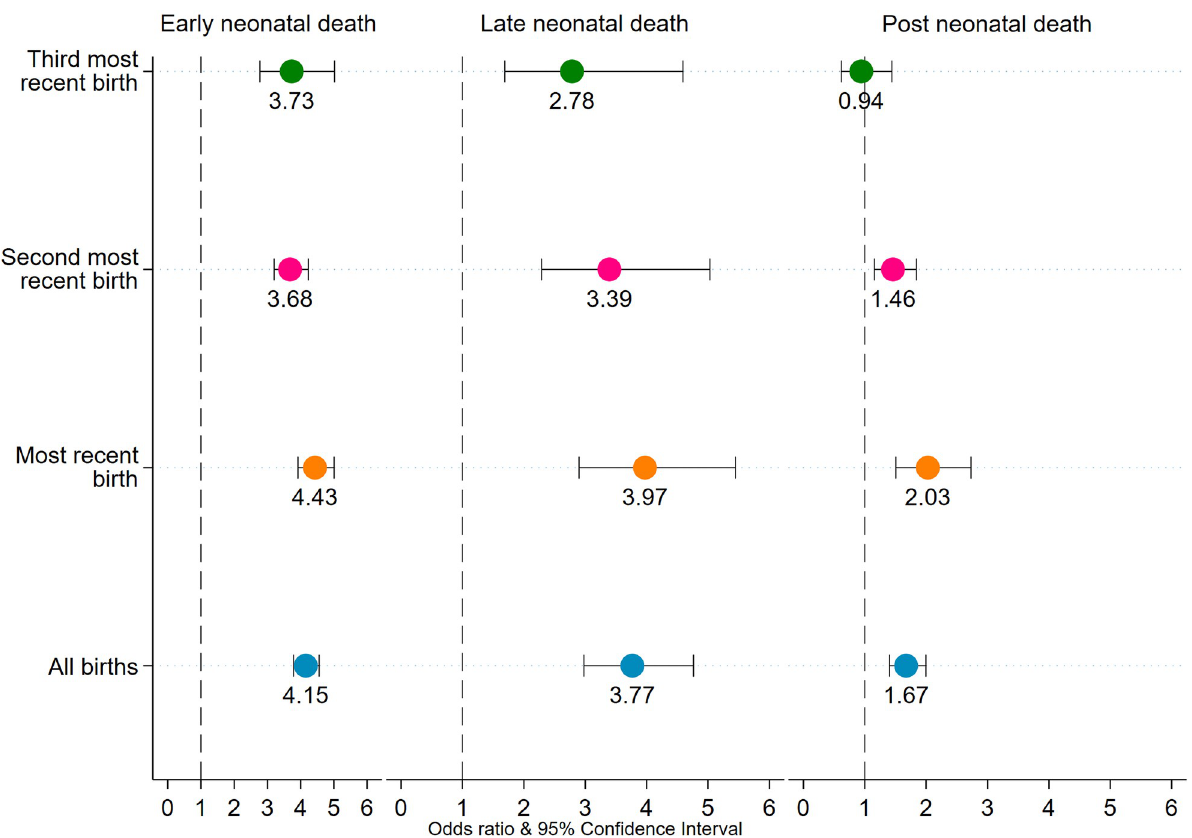
Fig 3. Adjusted odds ratio of ENND, LNND, and PNND for preterm birth, NFHS-4, India, 2015–16. Note. 1. Odds ratios are significant at p < 0.05. ENND Early Neonatal Death, LNND Late Neonatal Death, PNND Post Neonatal Death. Odds ratio are adjusted for birth order, index child c-section, index birth wanted, sex of child mother’s age at conception, mother’s height, mother’s schooling, caste, religion, wealth quintiles, urban-rural residence, and